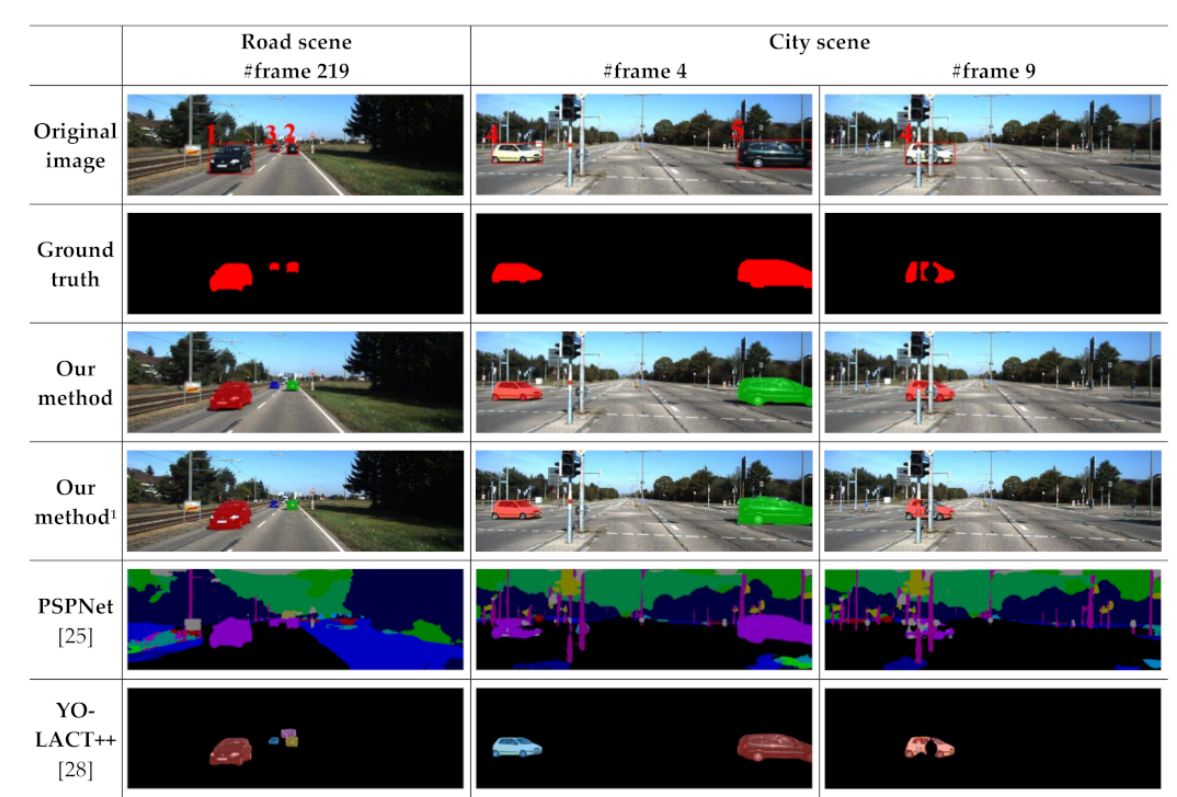
Figure 5. The segmentation results of three methods and ground truth in two traffic scenarios, including (1) Road scene; (2) City scene. Our method 1 indicates that our method only using color information without using optical flow, and